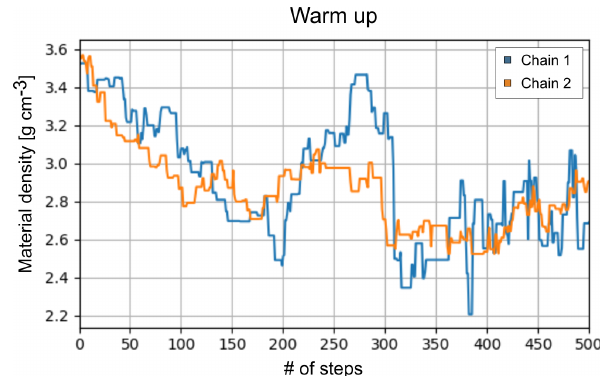
Figure 4. Example of a trace plot (two independent chains; blue and orange) of a MH run with 500 draws. This plot shows the parameter value (here material density) vs. number of steps of a collection of cones in which we (Nishyiama et al., 2017) knew that only rock is present. This is a calculation that is included in the code base. The warm-up phase of this MH algorithm takes roughly 150 simulations indicated by the subsequent oscillation around a parameter value of ∼ 27–28gcm − 3